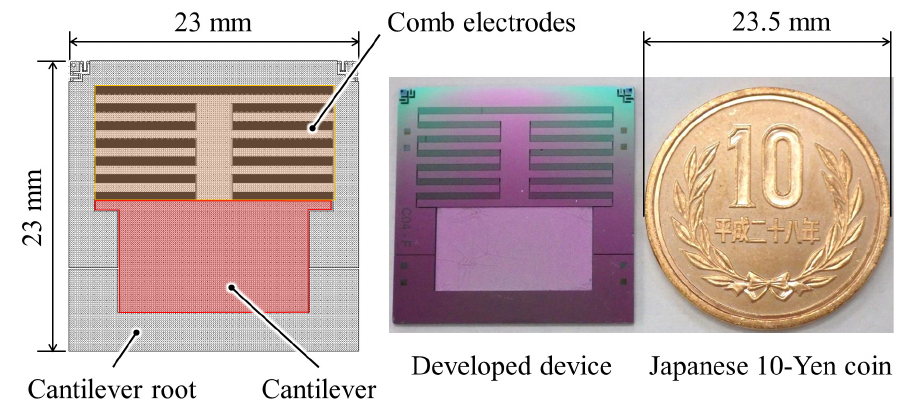
Figure 4. A photograph of fabricated device. Device size is 23 mm × 23 mm.